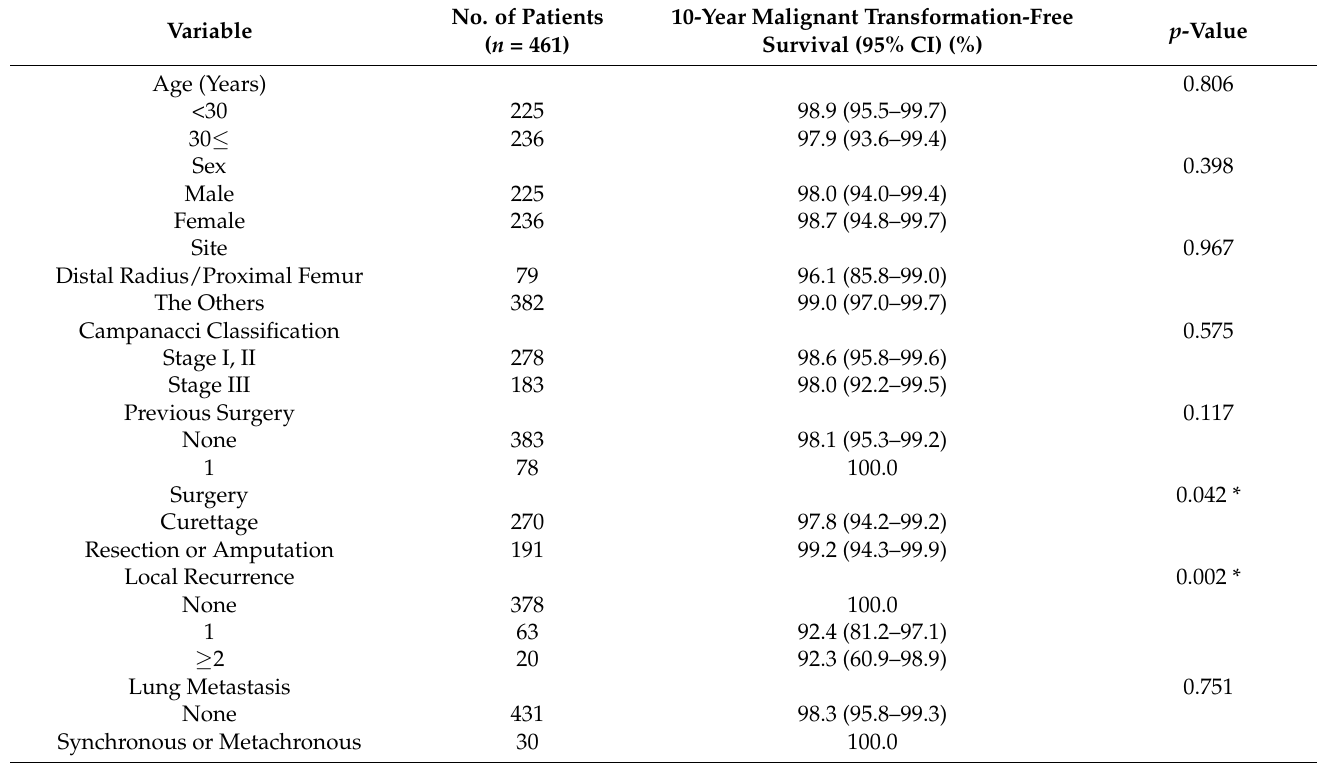
Table 4. Univariate analysis for malignant transformation-free survival in the patients with